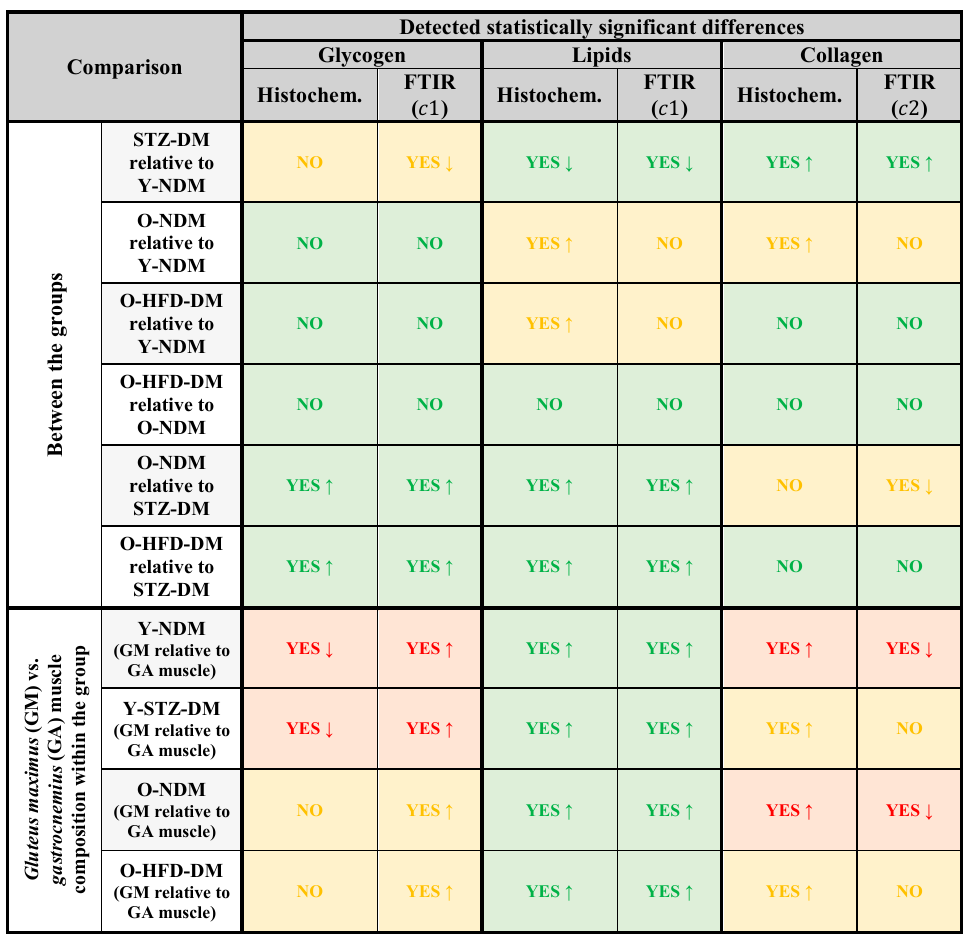
Figure 7 . Comparability of FTIR spectroscopy and histochemical methods for detecting statistical differences in skeletal muscle tissue composition in 13-week-old non-diabetic mice (Y-NDM), 13-week-old STZ-induced diabetic mice (Y-STZ-DM), 54-week-old non-diabetic mice (O-NDM), and 54-week-old HFD-induced obese insulin-resistant mice (O-HFD-DM). Green boxes show the complete agreement of histochemical methods and FTIR in detecting statistical differences (YES—a statistical difference detected, NO—a statistical difference not detected) and the trend of the differences ( ↑ increasing trend and ↓ decreasing trend relative to the reference). Yellow boxes show a disagreement in the detection of statistical differences. Red boxes show agreement in detected statistical differences but disagreement in the